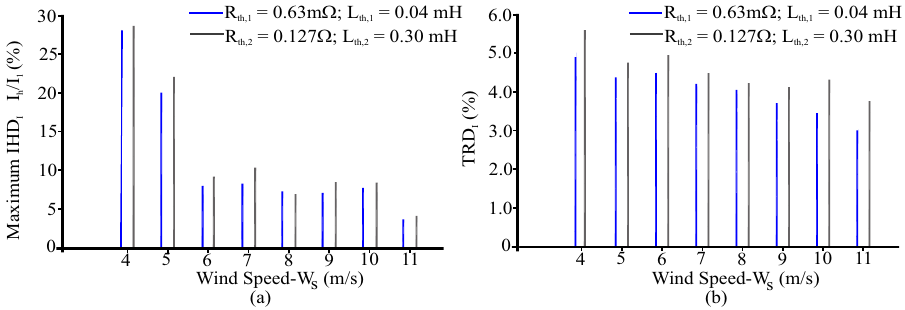
Figure 8. Distortion analysis versus wind speed ( W s ) for different grid Thevenin impedances. ( a ) Maximum Individual Harmonic Distortion ( IRD I , max -%). ( b ) Total Rated Distortion ( TRD I